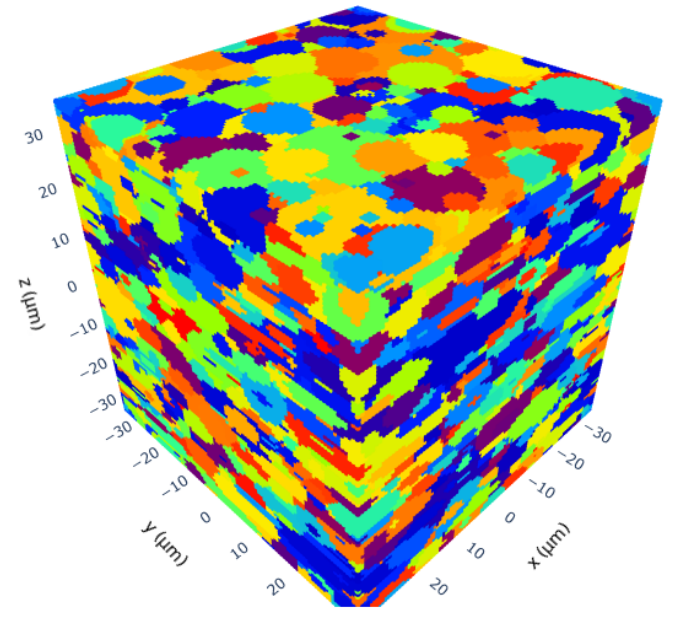
Figure 7. Final result after the discrete tessellation.